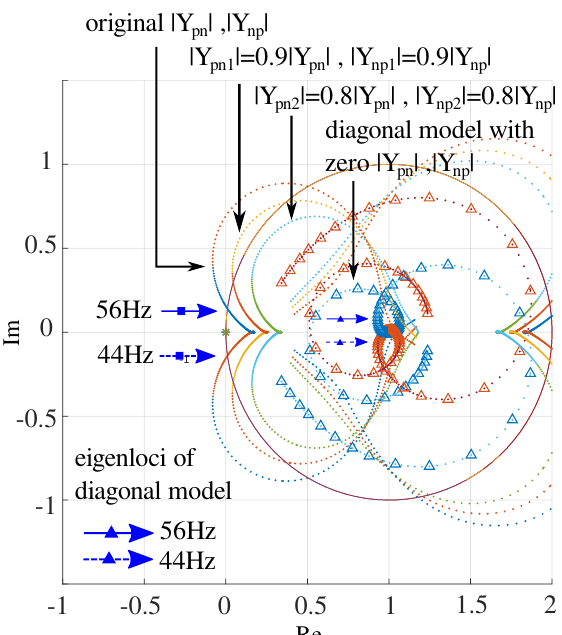
Figure 7. The impact of off-diagonal elements on the eigenloci near the fundamental frequency. The displayed frequency band is [30 Hz,70